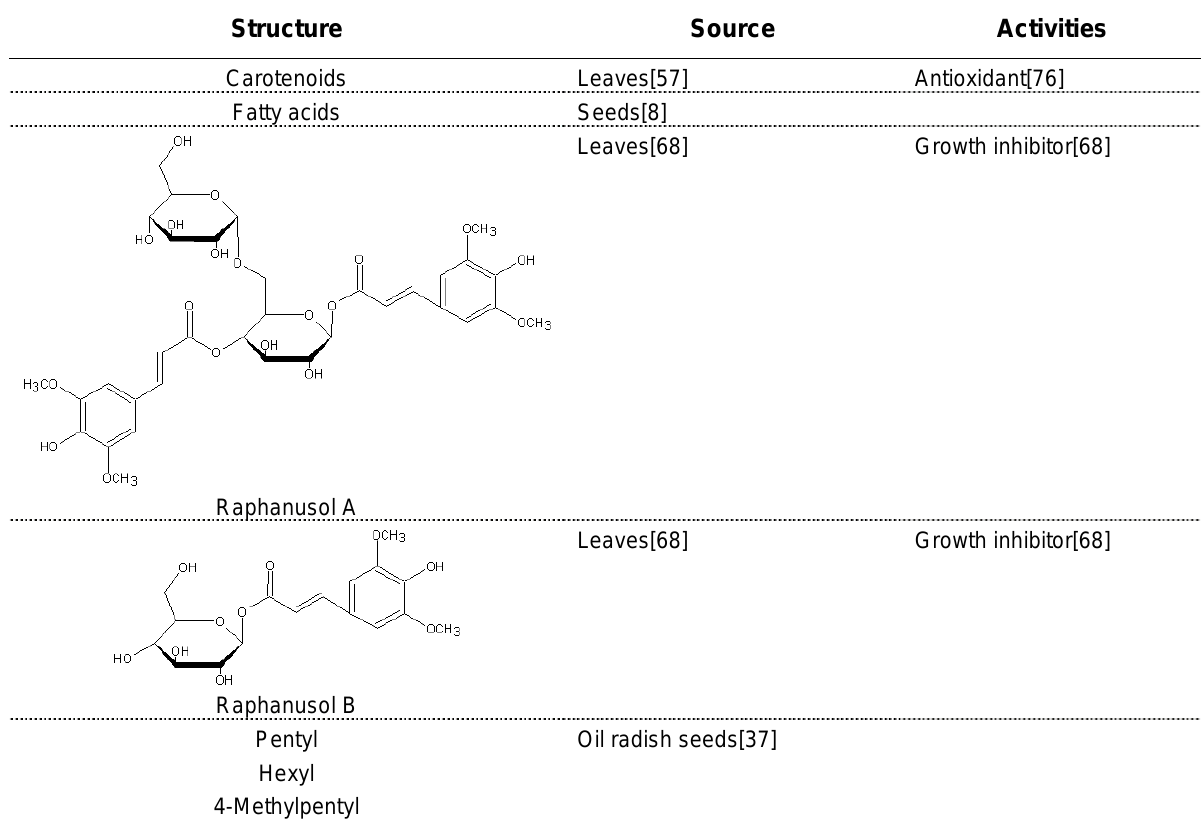
Other Compounds Isolated from